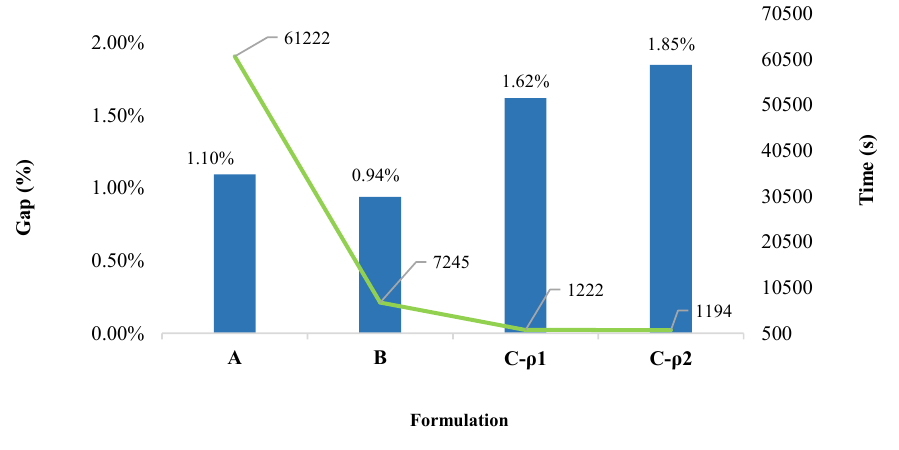
Figure 2. Optimality gap (%) and running time (s) for the different formulations on the server